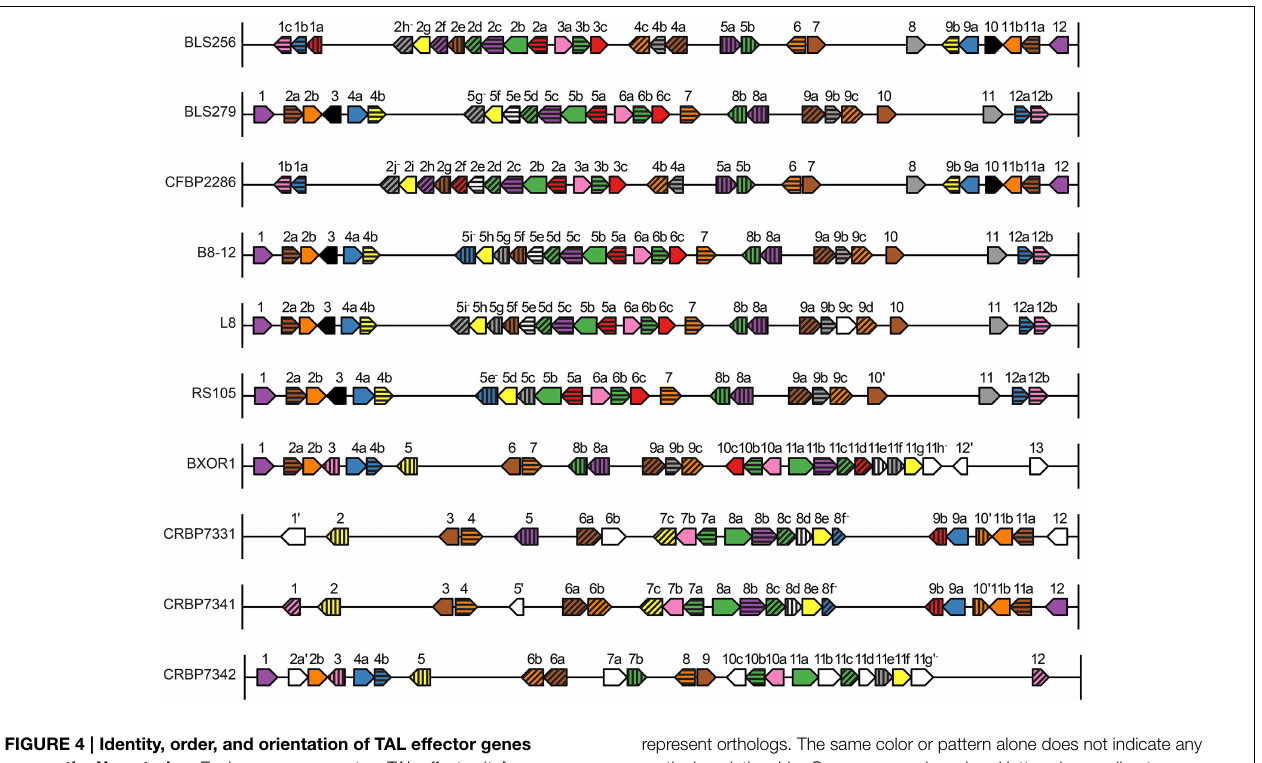
FIGURE 4 | Identity, order, and orientation of TAL effector genes across the Xoc strains. Each arrow represents a TAL effector ( tal ) gene and points in the 5 ′ to 3 ′ direction. The genes are to scale relative to one another, as are the intergenic regions, but the genes have been magnified relative to the rest of the genome. Arrows of the same color and pattern